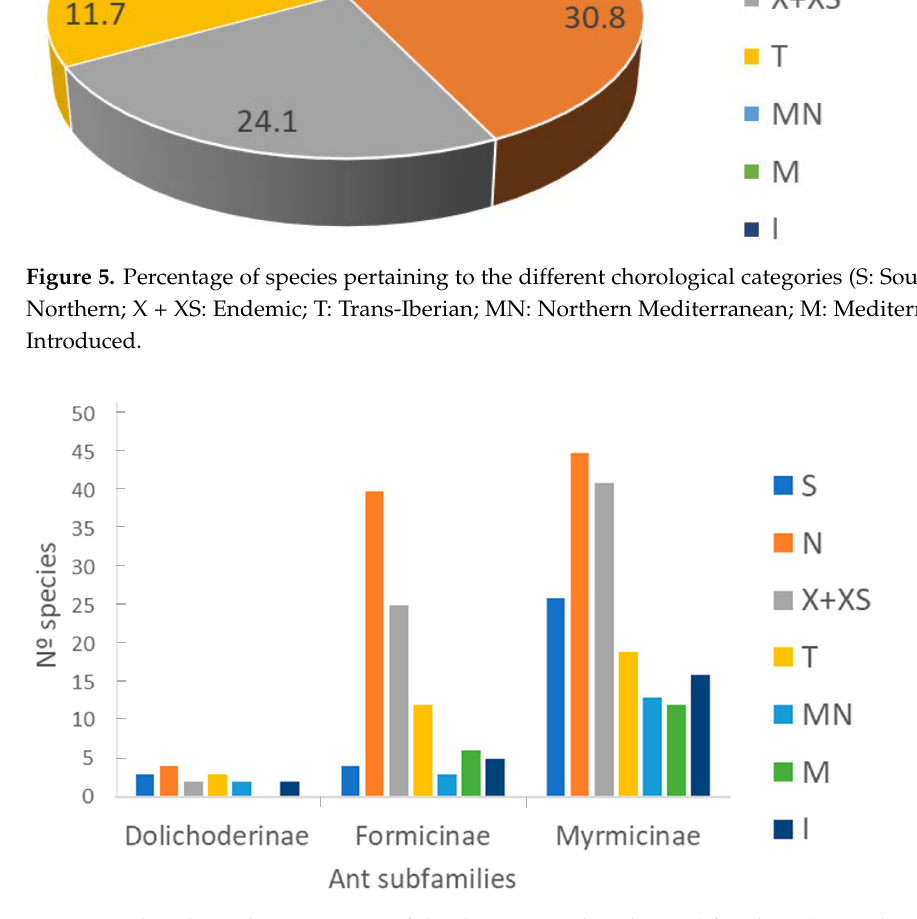
Figure 6. Chorological composition of the three more abundant subfamilies. (S: southern species, N: northern species, X + XS: endemic species, T: Trans-Iberian species, MN: north Mediterranean species, M: Mediterranean and I: introduced species).